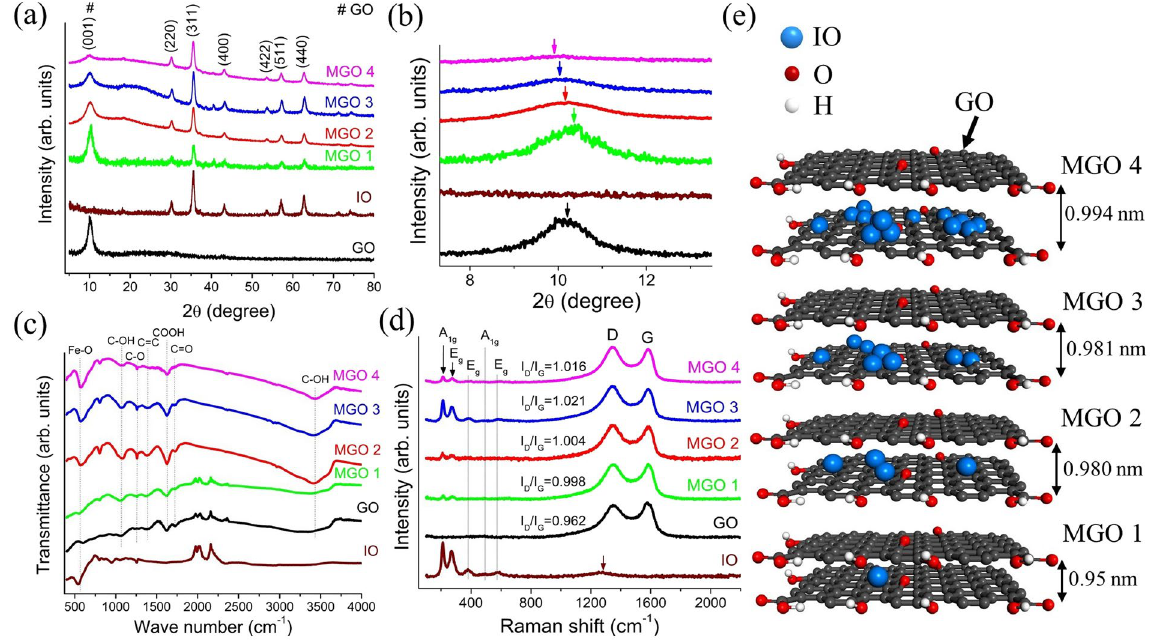
Figure 3. ( a ) XRD patterns of GO, IO, and MGOs. ( b ) XRD peaks shift corresponding to GO observed from ( a ). ( c ) Attenuated total reflectance Fourier transform infrared spectroscopy (ATR-FTIR) spectra of GO, IO, and MGOs. ( d ) Raman spectra of IO, GO and MGOs. ( e ) The schematic representation of IO aggregation in various flakes of GO in